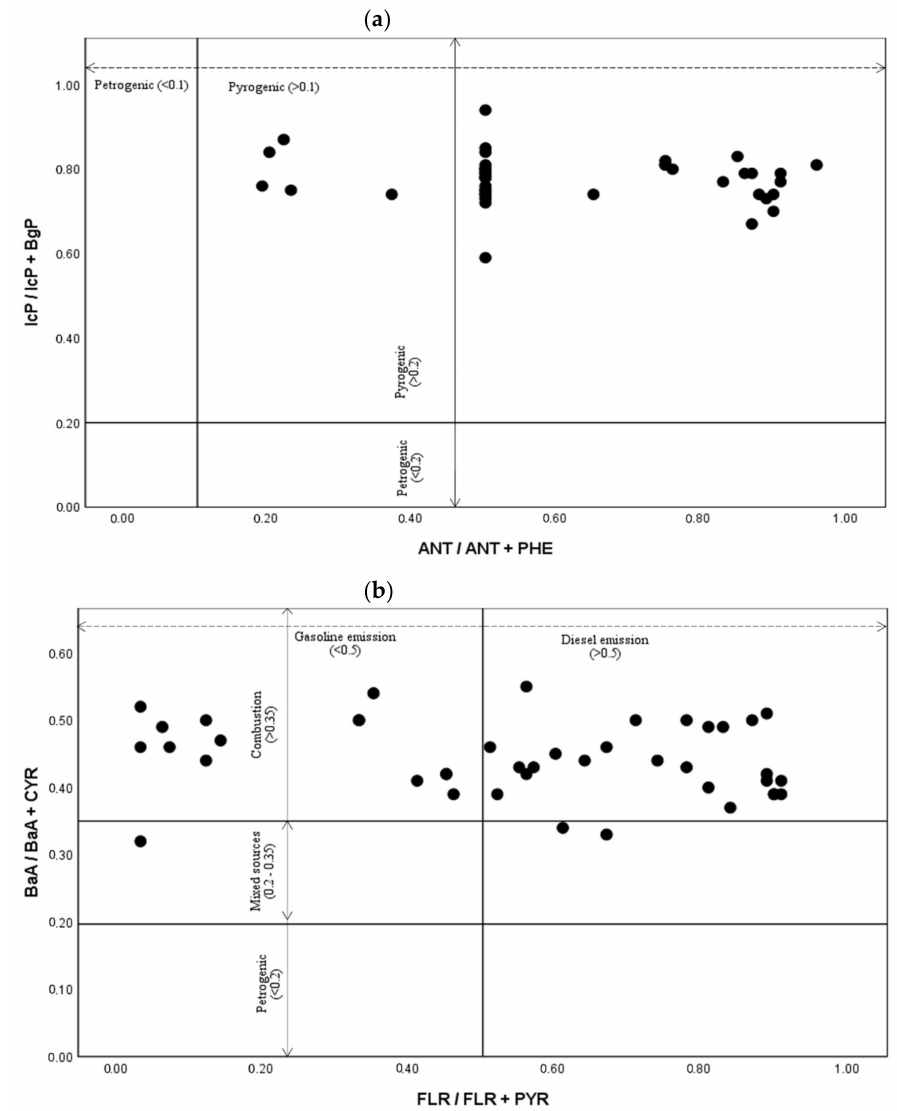
Figure 4. Result of source diagnostic ratio method. ( a ) IcP/IcP + BgP and ANT/ANT + PHE ( b ) BaA/BaA + CYR and FLR/FLR +